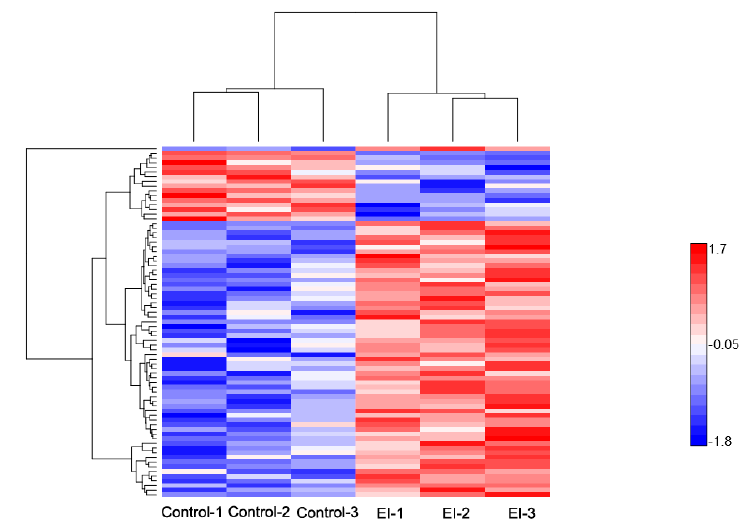
Figure 4. Hierarchical clustering of differentially-expressed proteins at the early disease stage. Heat map showing the changes in protein expression: Proteins with high expression levels (red); proteins with low expression level